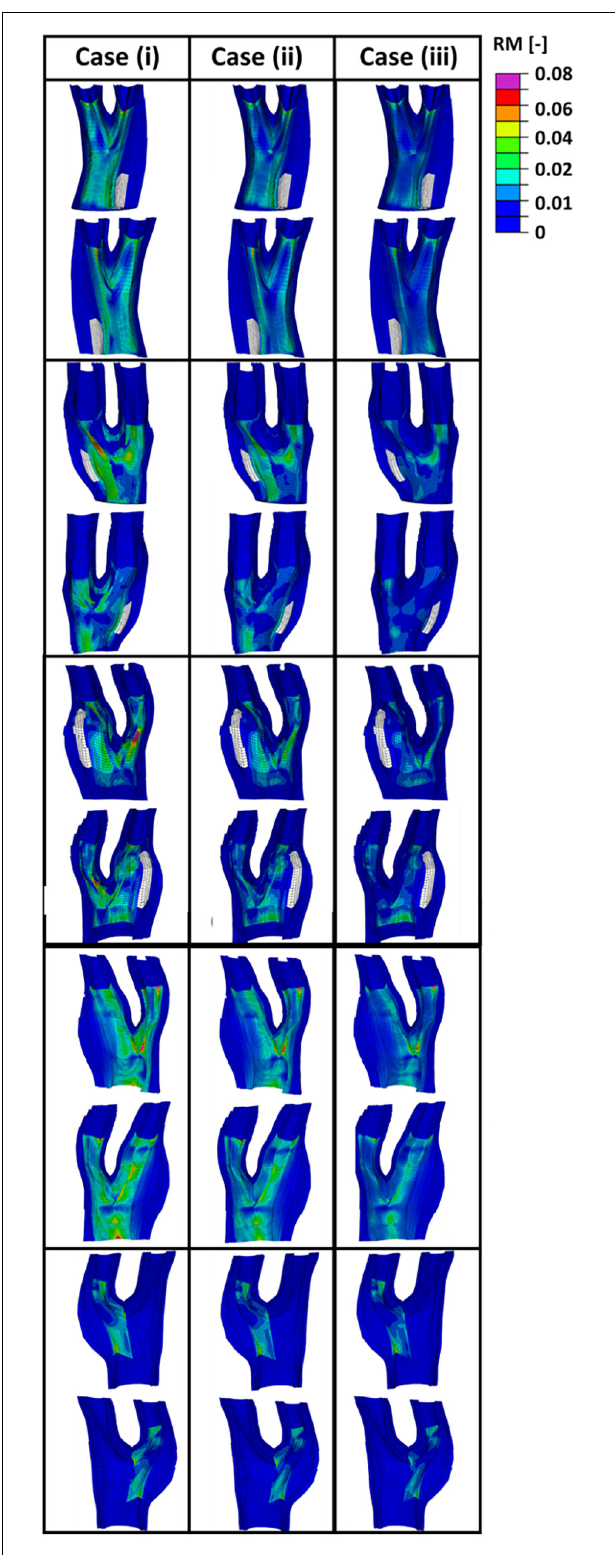
FIGURE 11 | The values obtained for the remodelling metric (RM) during the remodelling process.